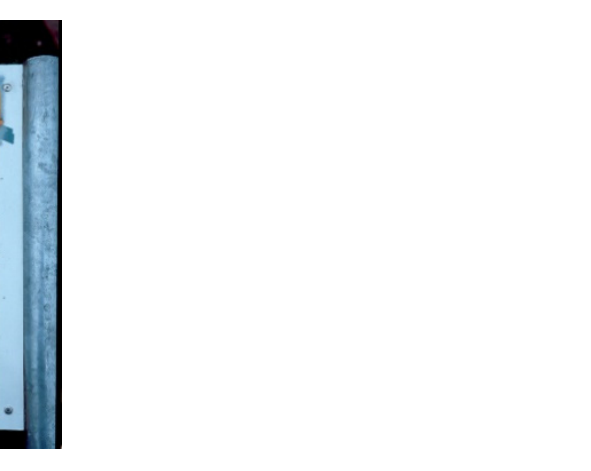
25 of 39 Figure 15. Wooden board in the Bavarian Forest National Park (Germany) with writing difficult to read (Megerle 2000).